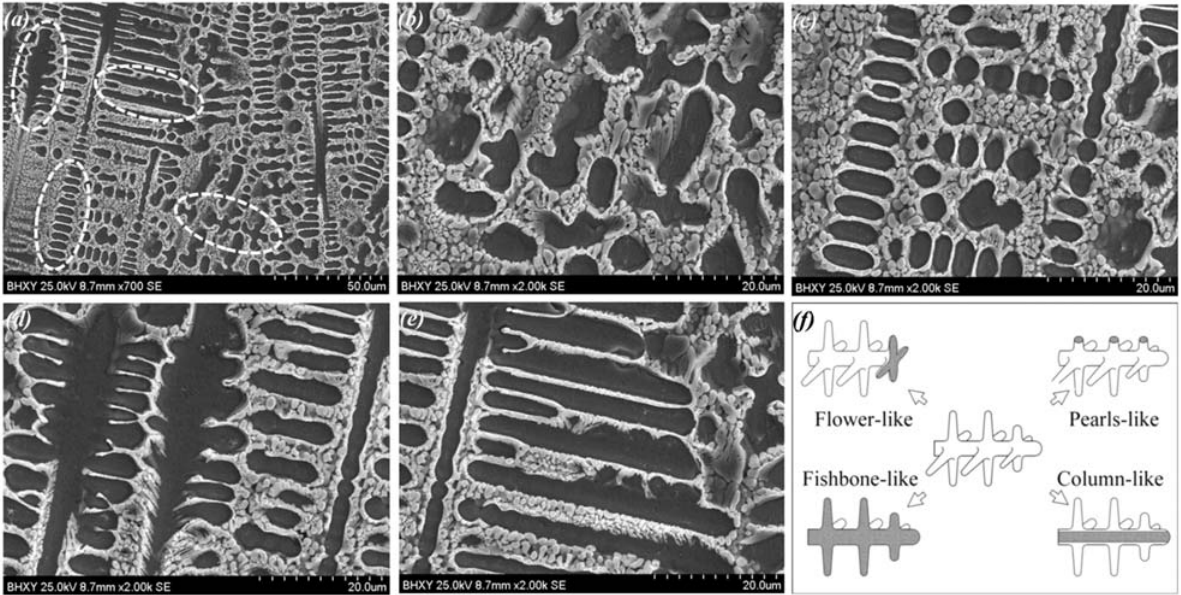
Figure 6. SEM morphologies of the Ni35 coatings fabricated at 5 kW, 200 mm/min: ( a ) various dendrite morphologies, ( b ) flower ‐ like morphology, ( c ) pearl ‐ like morphology, ( d ) fishbone ‐ like morphology, ( e ) column ‐ like morphology, and ( f ) schematic illustration of the sectioning effect.